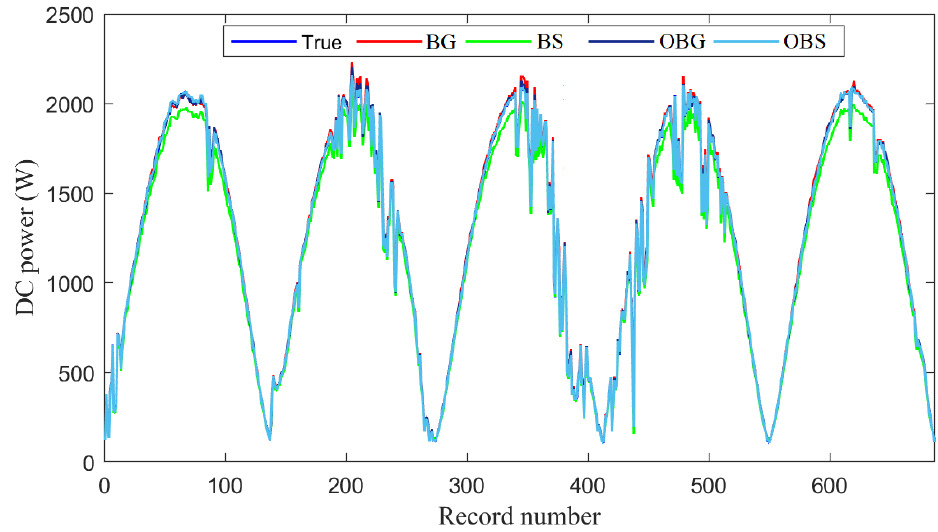
Figure 7. Power prediction using BG, BS, OBG, and OBS models based on training data.